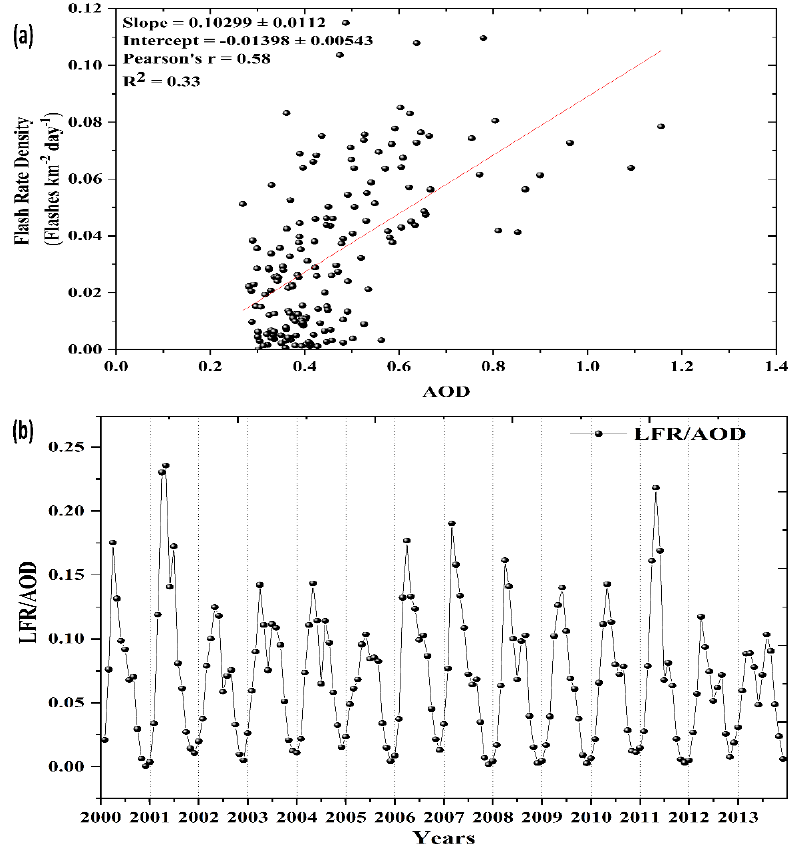
Figure 10. ( a ) Scatter plot between monthly flash rate density and AOD for the whole study period; ( b ) time series plot for the ratio of LFRD to the AOD of each month’s data from 2000 to 2013 over the study region.